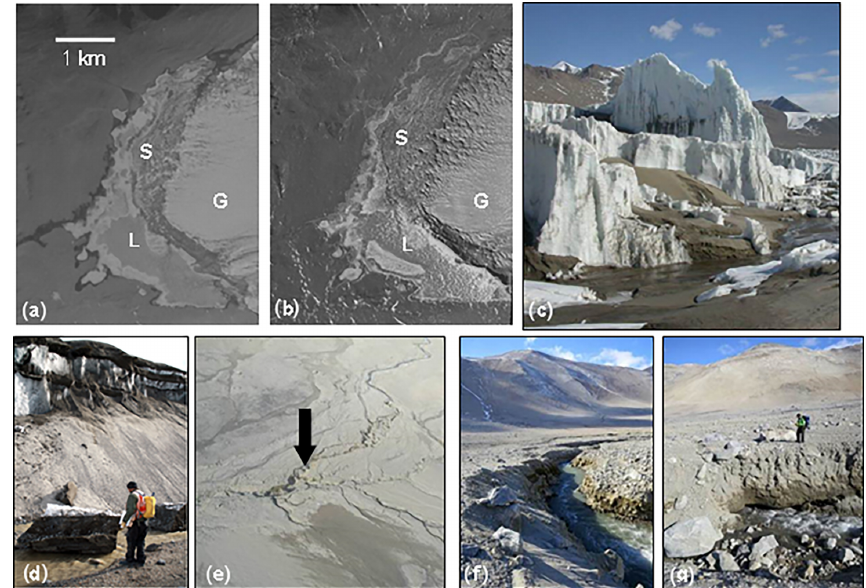
Figure 2. Examples of ice-mediated elevation changes in the McMurdo Dry Valleys. Disintegration of the lower ablation zone of the Wright Lower Glacier, Wright Valley, (a) 1980 and (b) 2008. S is the sediment-covered part of the glacier, G is the relatively clean part of the glacier, and L is Lake Brownworth. The dots just below the S in the 2008 photo are ice spires several meters tall with sediment-covered ablated ice surrounding it, depicted in (c) , photo: M. Sharp. (d) Ice cliff exposed by the eroding Garwood River. (e) Aerial view of Garwood River incision and bank collapse. River flows right to left. Arrow points to where photos (f) and (g) were taken. (f) Recent incision; note color differences. (g) The river has carved a thermokarst tunnel.